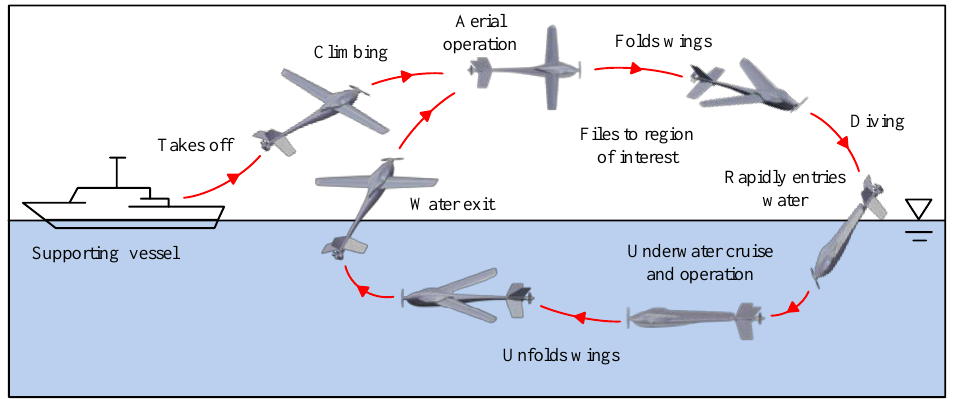
Figure 2. Schematic sketch of operational regimes of the UAUV.